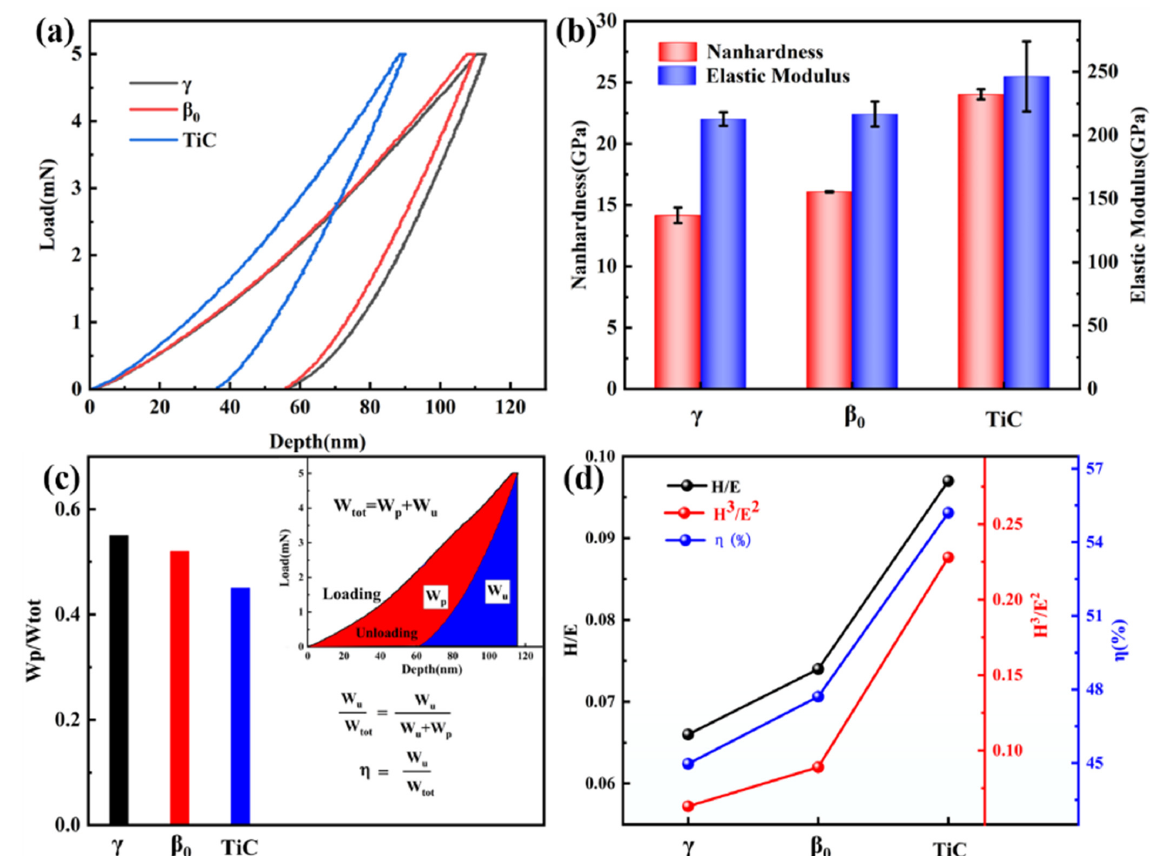
Figure 9. ( a ) Load–depth curves for nanoindentation of γ β 0 and TiC phases. ( b ) Nanohardness and elastic modulus results for γ β 0 and TiC phases. ( c ) The W p /W tot results for γ β 0 and TiC phases, where the areas are represented by W p , Wu, and Wtot. ( d ) H/E, H 3 /E 2 , and η comparison of results. Table 3. Specific results of nanoindentation of TiAl composite coatings.